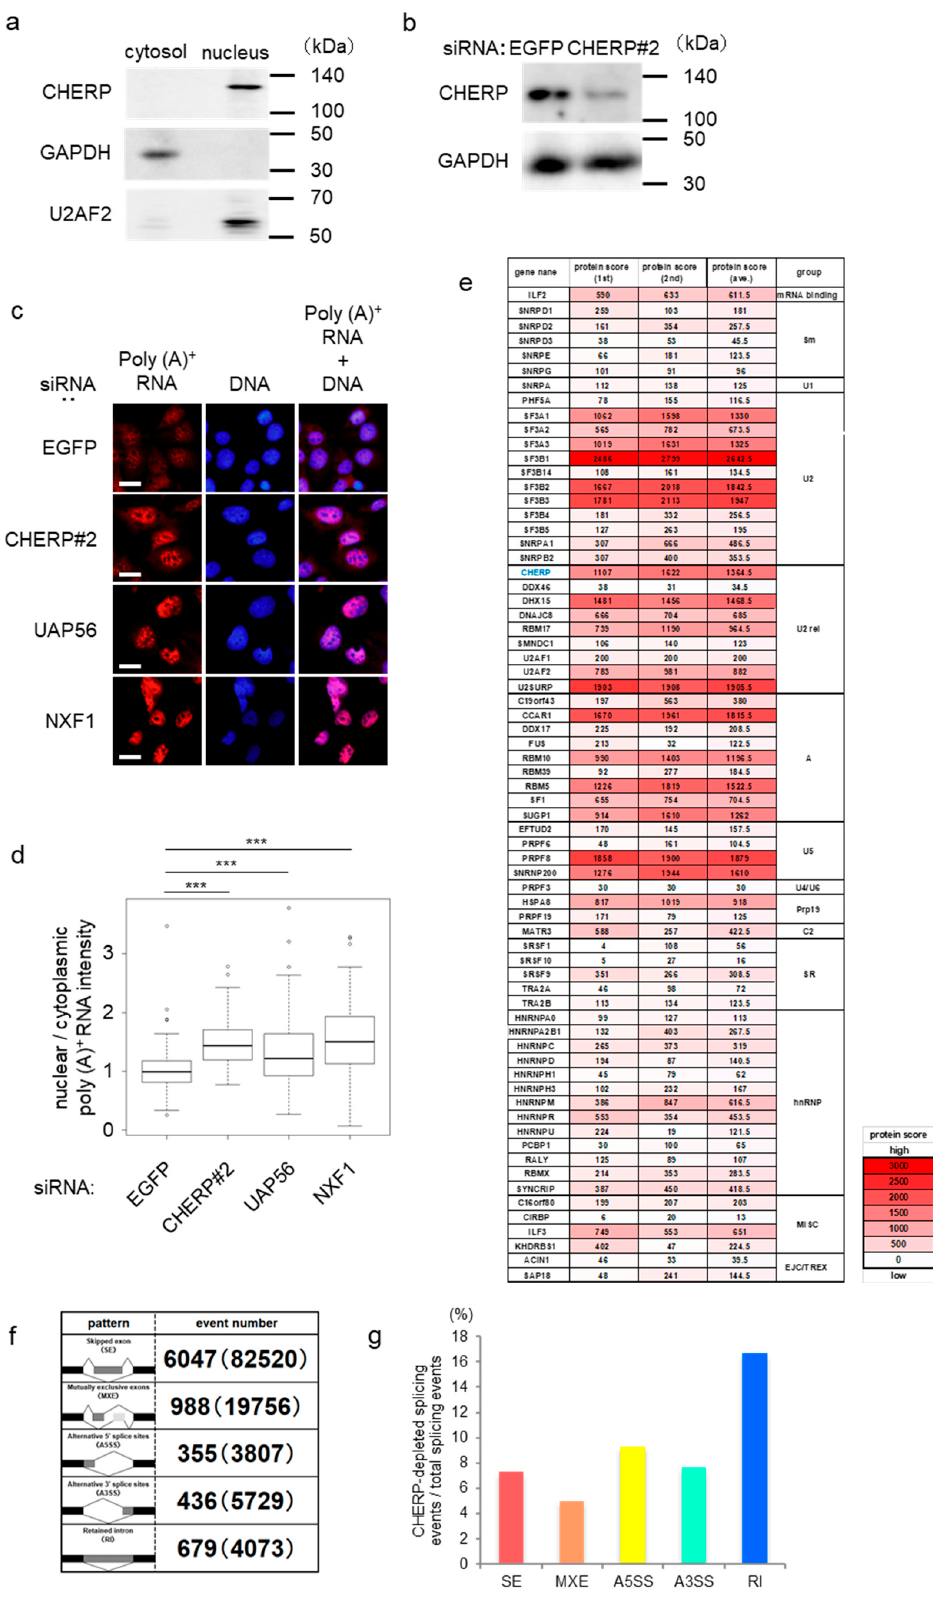
Figure 1. Calcium homeostasis endoplasmic reticulum protein (CHERP) is involved in